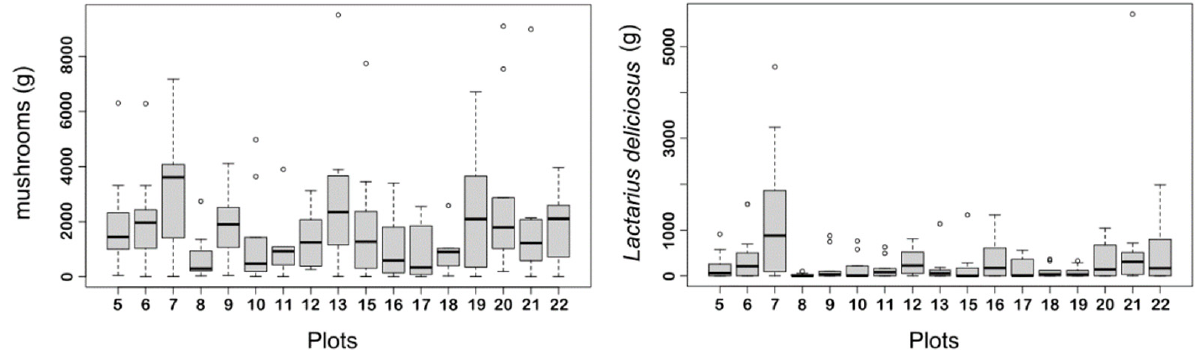
Figure 2. Statistical characterization of annual mushroom yield (g) in the experimental network of plots during the period 2012–2021. ( left ): total mushroom biomass and ( right ): Lactarius deliciosus biomass.